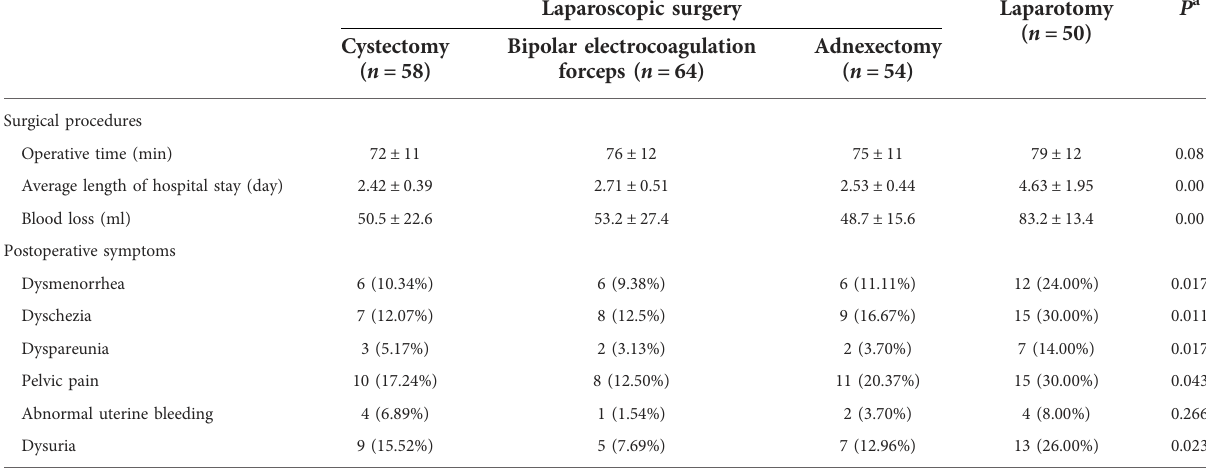
TABLE 2 Surgical procedures and postoperative symptoms for laparoscopic surgery and laparotomy for